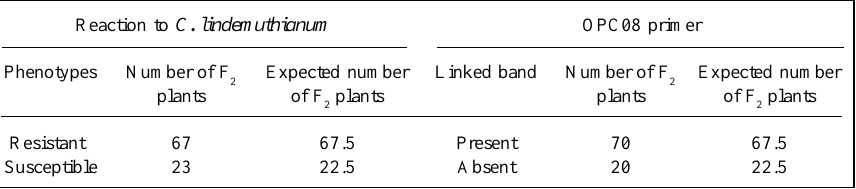
Table I - Number of F plants with phenotypes resistant or susceptible to Colletotrichum lindemuthianum, 2 and the occurrence of a linked band produced by the primer OPC08, for the cross Carioca 300V x P45.